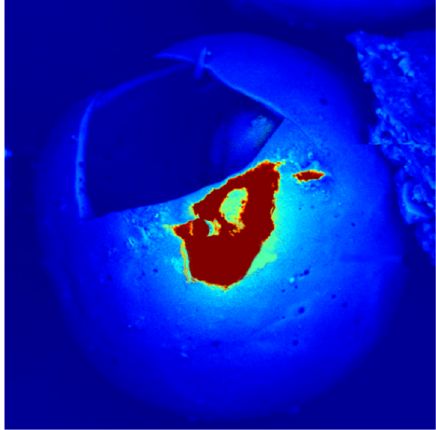
Figure 5. SEM microphotographs: CS fraction F_212 detail; we observed smaller CSs inside larger ones, mag. × 2770.